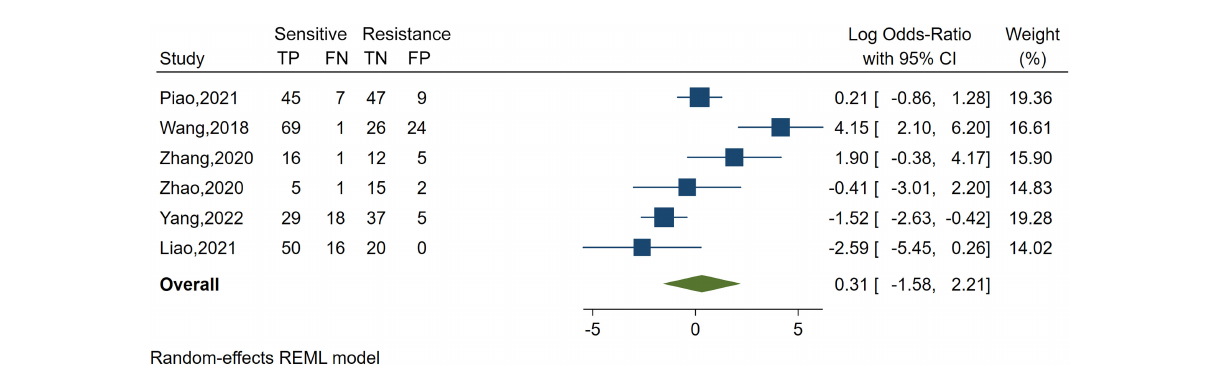
FIGURE 4 | Forest plot of the study outcome, as evidenced by the log odds ratio of six included meta-analysis studies examining the radiomics accuracy in predicting the treatment response to neoadjuvant chemotherapy in treating nasopharyngeal carcinoma. TP, number of patients correctly predicted in the sensitive group; FN, number of patients incorrectly predicted in the resistance group; FP, number of patients incorrectly predicted in the sensitive group; TN, number of patients correctly predicted in the resistance group; x-axis, log-transformed odds ratios; REML, restricted maximum